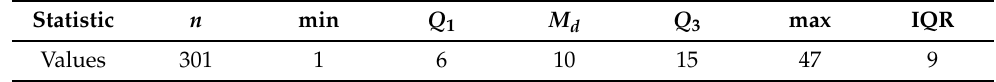
Table 13. Descriptive statistics for the COVID-19 data set of